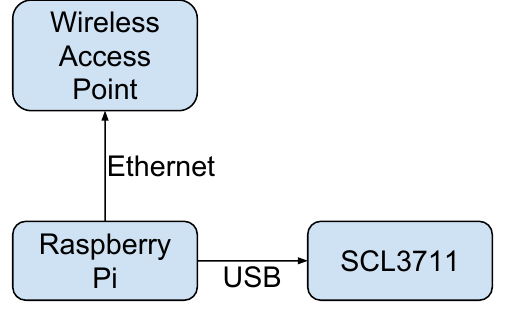
Figure 2. Prototype components